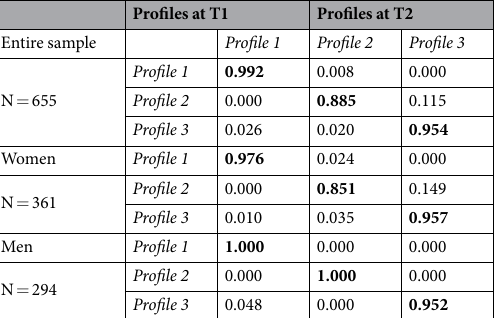
Table 3. Latent Transition Probability matrices in Sample 1. The table describes the latent transition probabilities over the 4 years period in Sample 1. Each cell in the matrix represents the probability to be classified in the profile in column j (at T2), conditioned to the probability to have been classified in the profile in the row i (at T1)